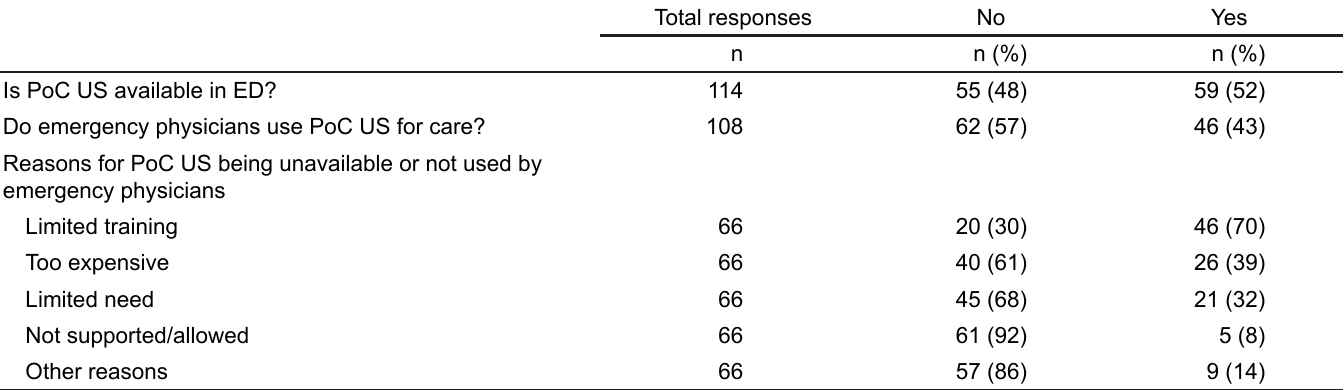
Table 2. Reasons for use of point-of-care ultrasound by emergency physicians in four states (n=123 emergency departments).